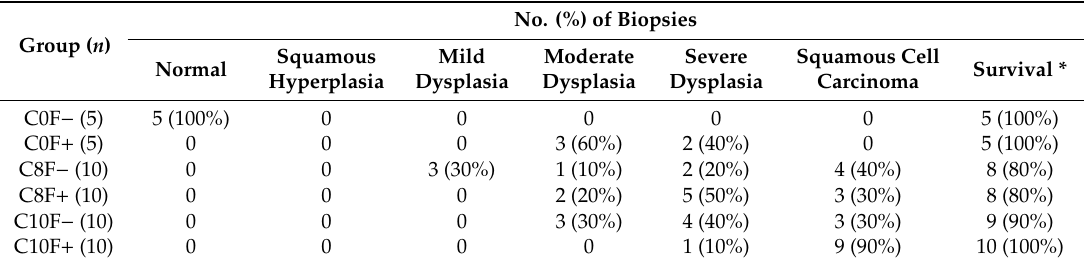
Table 1. Histopathological changes in the tongue tissues of mice in each group.